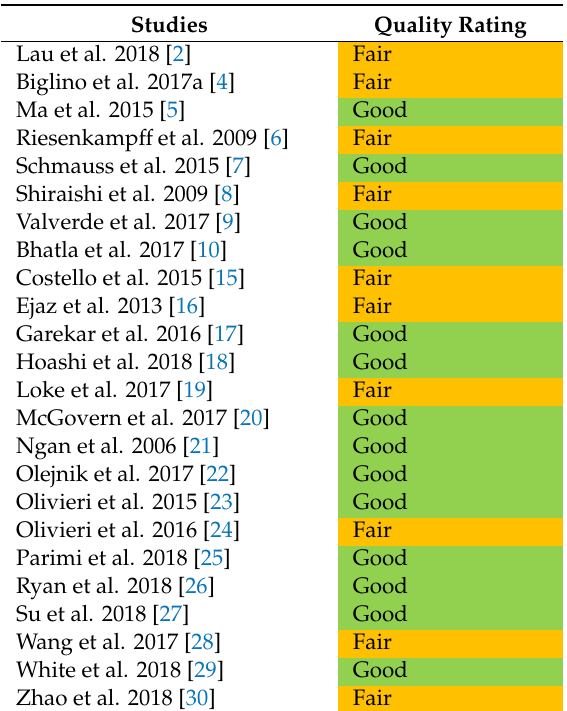
Table 2. Quality of the included studies assessed by National Institute of Health assessment